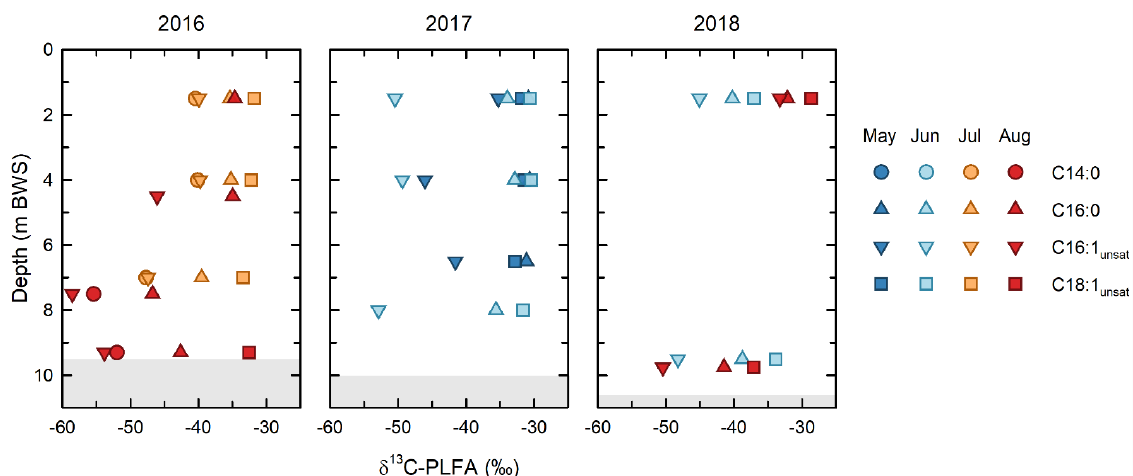
Figure 6. PLFA isotopic compositions for indicator PLFA, including pooled C16:1 PLFA, which include methanotroph biomarker PLFA, C14:0 PLFA also produced by methanotrophs (2016 only), pooled C18:1 PLFA produced by non-methanotrophic organisms, and C16:0 produced by all organisms. Depth is below water surface.